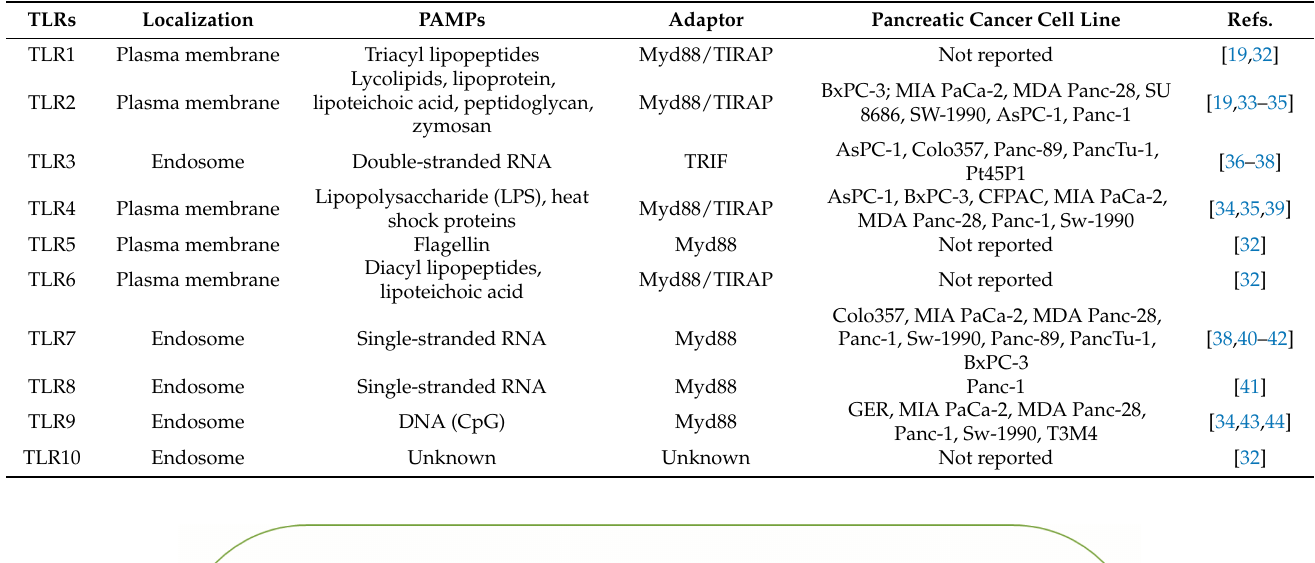
Table 1. Toll-like receptors expressed in human pancreatic cancer cell lines.